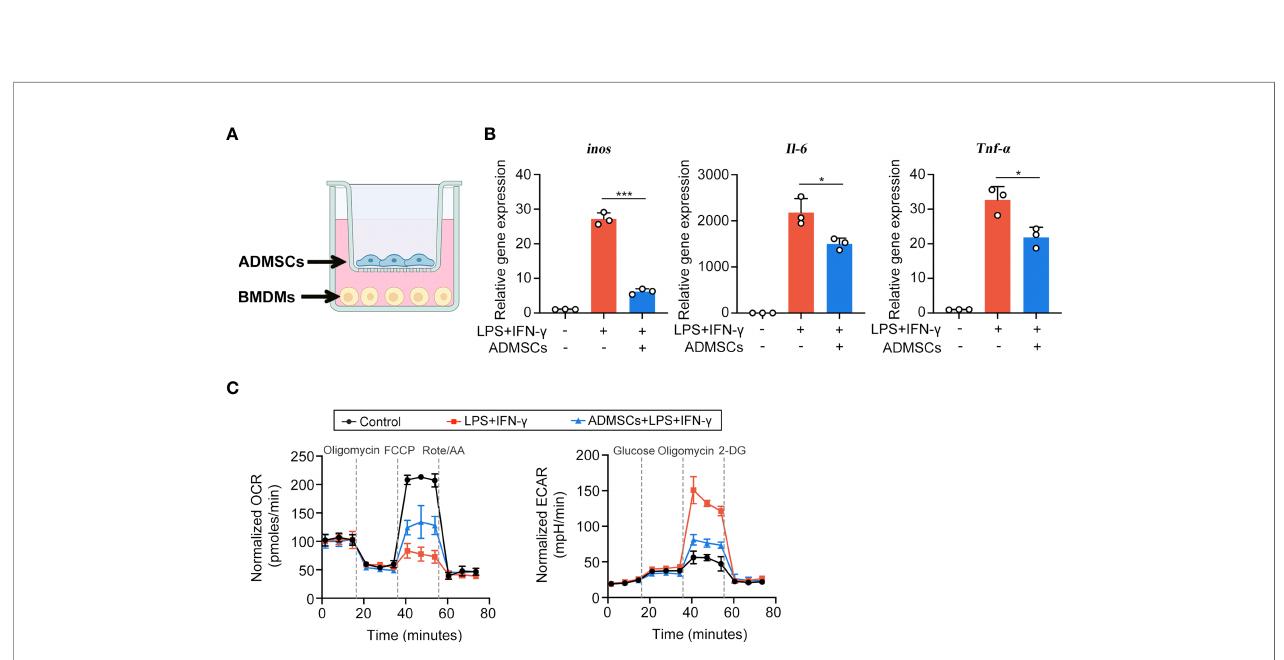
FIGURE 3 | ADMSCs inhibited the M1 polarization and glycolytic pathway in macrophages. (A) Schematic diagram of the co-culture system. (B) qRT-PCR analysis of M1-characterized genes including iNOS, IL-6 and TNF- a . (C) Oxygen consumption rate (OCR) and extracellular acidi fi cation rate (ECAR) values of BMDMs with different treatments. (*p < 0.05; ***p <